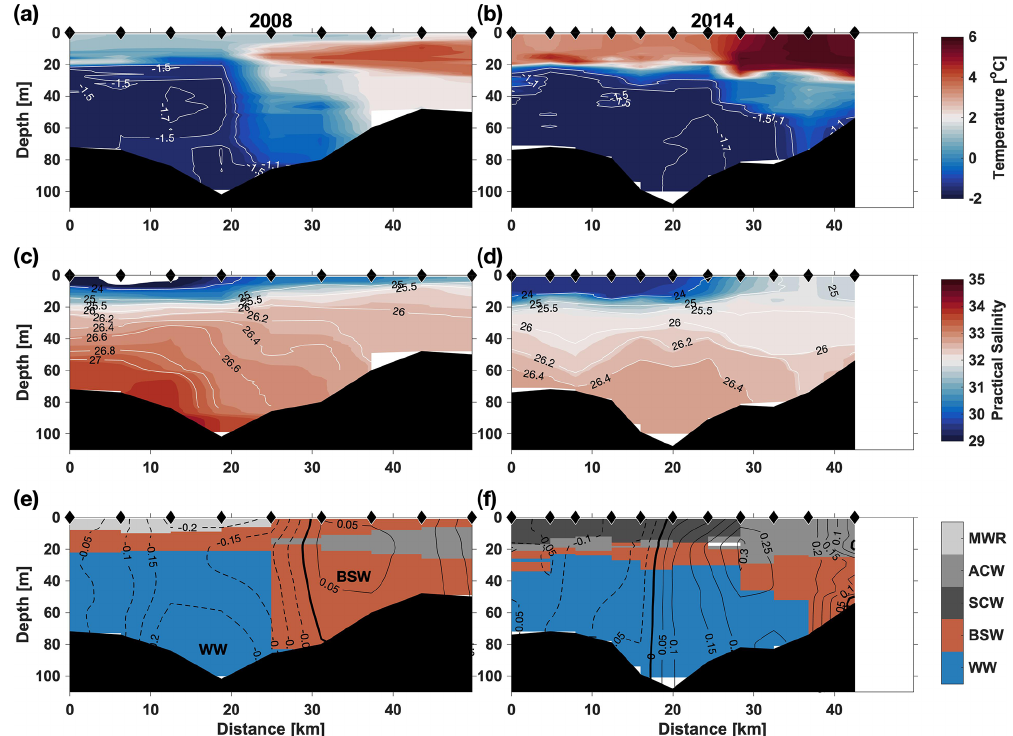
Figure 4. Temperature (a, b) , practical salinity (c, d) for section 3 at approximately 72 ◦ 20 (cid:48) N (Figs. 1b and 2) in 2008 (a, c, e) and 2014 (b, d, f) . Panels (e) and (f) show the spatial distribution of water masses as defined following Linders et al. (2017) (see also Fig. 3) together with cross-section velocities (ms − 1 ) computed as described in section 2.2. Solid contours denote northward (positive) velocities, while dashed ones represent southward (negative) ones. The white contours in panels (a) and (b) show the temperature structure in the WW. Those in panels (c) and (d) are potential density σ 0 (kgm − 3 ). Table 1. Mean properties of the Winter Water (WW) and Bering Summer Water (BSW) observed in 2008 and 2014. Water mass Salinity